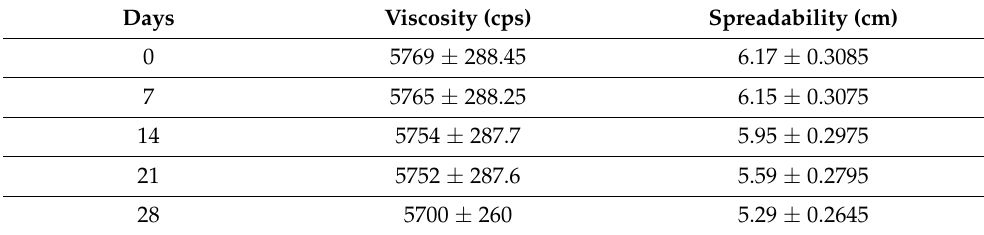
Table 1. Viscosity and spreadability of AEO emulgel for 1–28